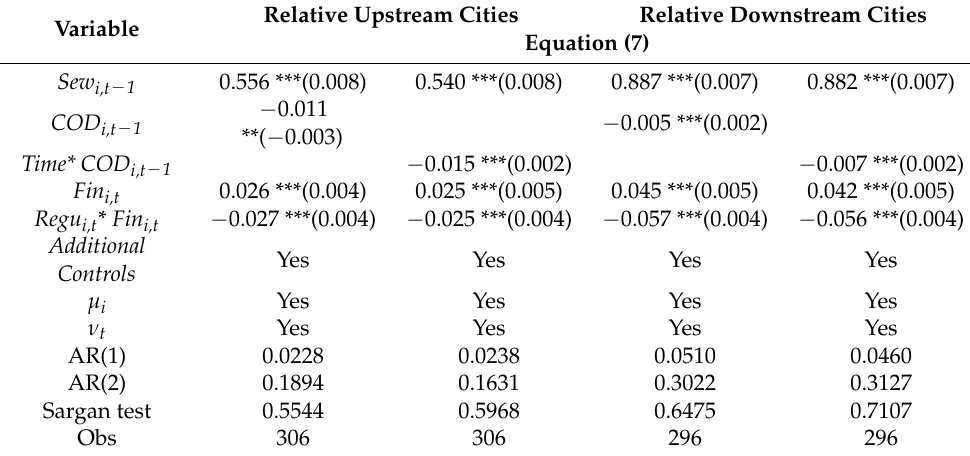
Table 7. Comparison of the governance effects of two typical rivers on relative upstream and relative downstream cities. Relative Upstream Cities Relative Downstream Cities Variable Equation (7) Sew i,t − 1 0.556 ***(0.008)